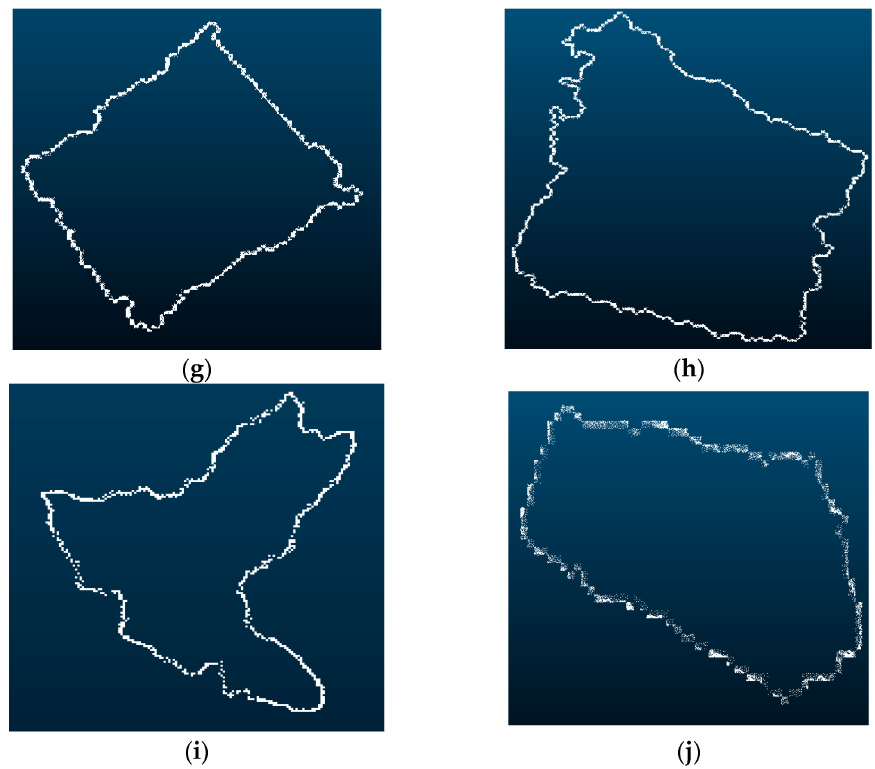
Figure 7. Results of boundary point extraction of the ten experimental 3D models. ( a – j ) are the results of boundary point extraction of water regions in model_01, model_02, model_03, model_04,